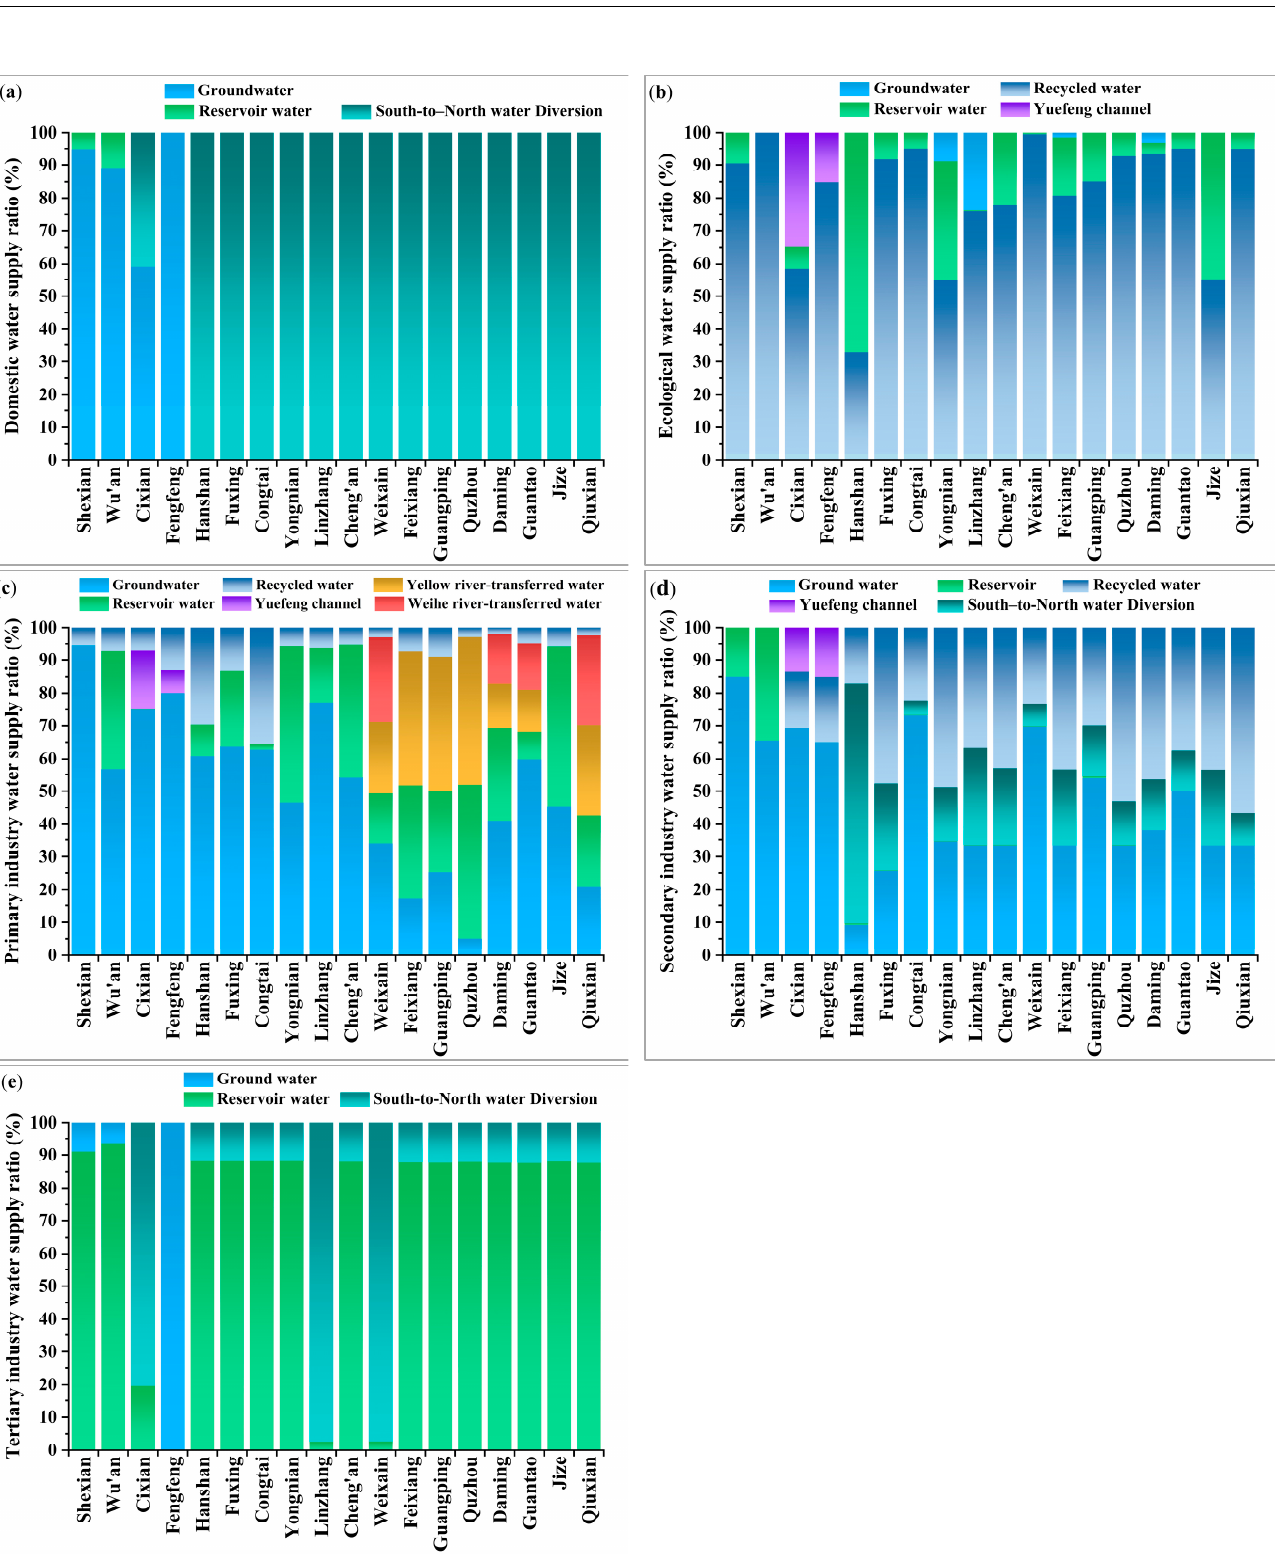
Figure 7. The proportion of water supply from different industries in each administrative district of Handan. ( a ) Domestic, ( b ) Ecological, ( c ) Primary industry, ( d ) Secondary industry, ( e ) Tertiary industry.